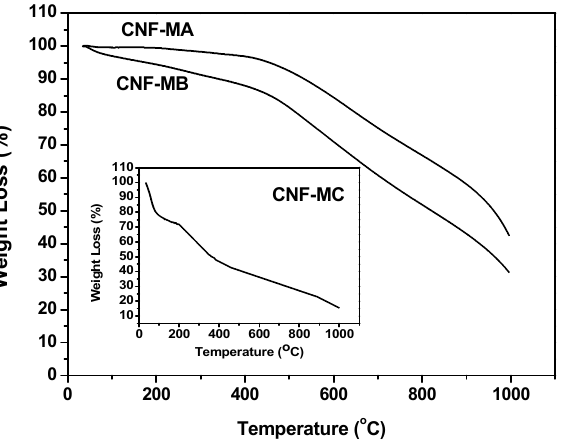
Figure 10. TGA curves representing the weight loss of the CNF ‐ MA (>400 °C), CNF ‐ MB (>450 °C), and CNF ‐ MC (>180 °C).